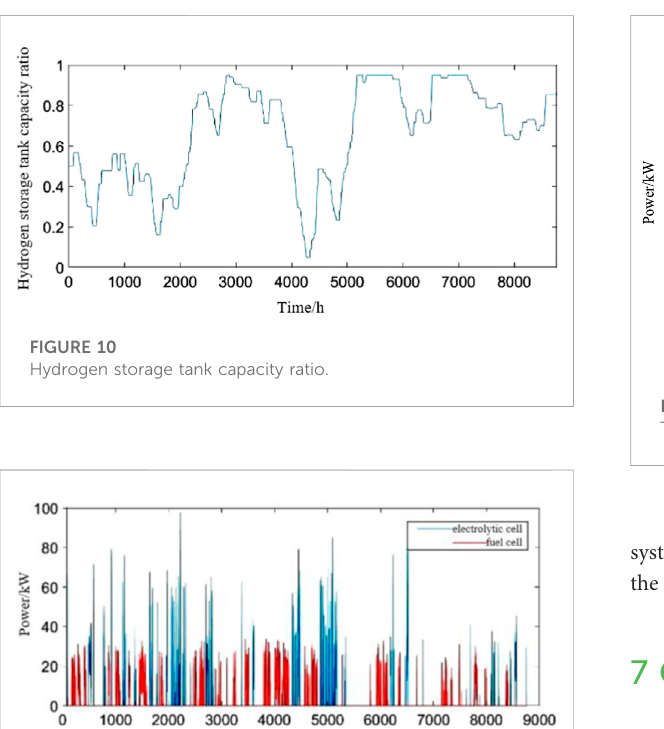
FIGURE 11 Electrolytic cell and fuel cell power.